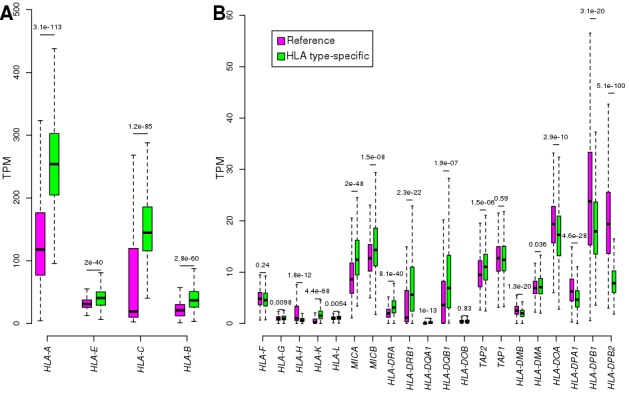
Comparing reference and HLA type-specific TPM.For each of the 24 expressed HLA genes, boxplots show the distribution of TPM calculated by aligning RNA-seq reads to reference cDNA sequences (purple) and by aligning to HLA type-specific cDNA sequences (green): (A) shows the four HLA genes with highest expression levels (TPM >20); and (B) shows the HLA genes with mean TPM <20. To compare reference and HLA type-specific expression levels (TPMs), we transformed the HLA type-specific expression levels to gene-level expression by summing the expression of the two HLA types in each individual. Nominal p-values are shown for each gene (calculated using paired t-test between reference and HLA type-specific TPM in each sample). The HLA class I genes, which are expressed ubiquitously, tended to be expressed significantly higher using HLA type-specific alignments, whereas most class II genes, which are expressed mostly in immune cells, were expressed significantly lower in the iPSCs using the HLA type-specific alignments. For instance, we observed that in many samples the expression of HLA-C was low (<40 TPM) using reference alignments, but it increased more than four-fold using HLA-specific alignments; while HLA-DPB2 expression decreased in 98% of samples. Our analyses (here and in Figure S3) and those of others (Aguiar et al., 2019; Panousis et al., 2014) suggests that HLA gene expression level estimates are improved by aligning RNA-seq reads to HLA type-specific cDNA sequences.